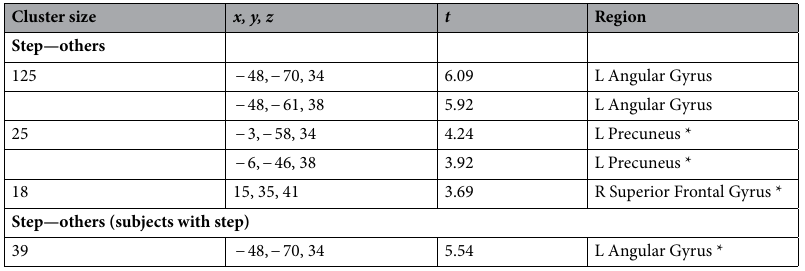
Table 3. Post hoc analysis of step filter condition > all other filter conditions masked by using the above ANOVA results. Step—Others (the upper part) is the result for all subjects for this contrast, and the lower part is the result for subjects who rated the voice with the step filter to be most similar to the own-voice. Contrasts were significant at a voxel-level threshold of p < .001 combined with an FWE correction of p < .05 for cluster size. MNI coordinates and t -scores are from the peak voxels of a cluster. *Contrasts were significant at a peak voxel threshold of p < .001 (uncorrected), with no cluster